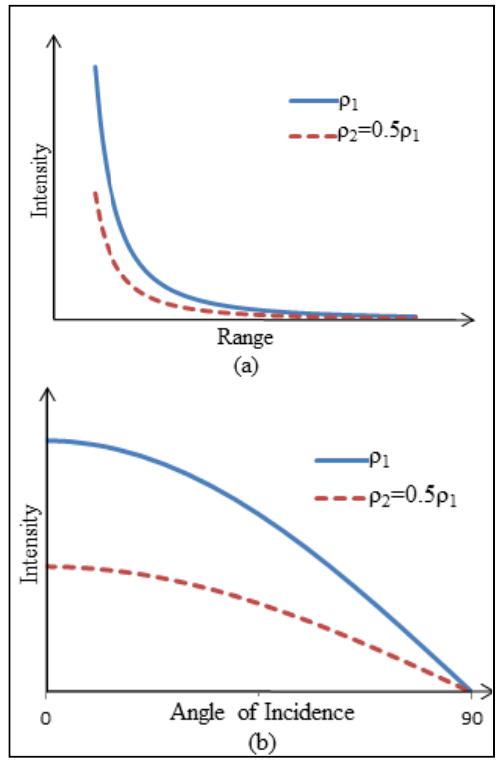
Figure 1. Theoretical model of beam attenuation by the distance (a) and the angle of incidence (b) for two diffusely reflecting surfaces ( 𝜌 2 = 0,5𝜌 1 ) (Kashani et. Al,